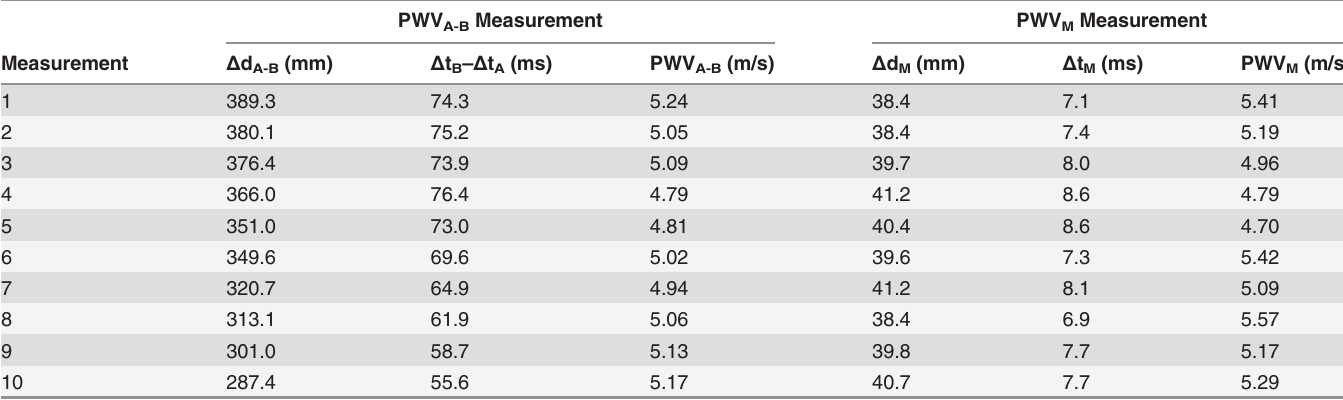
Table 1. The PWV measurements by the in vitro